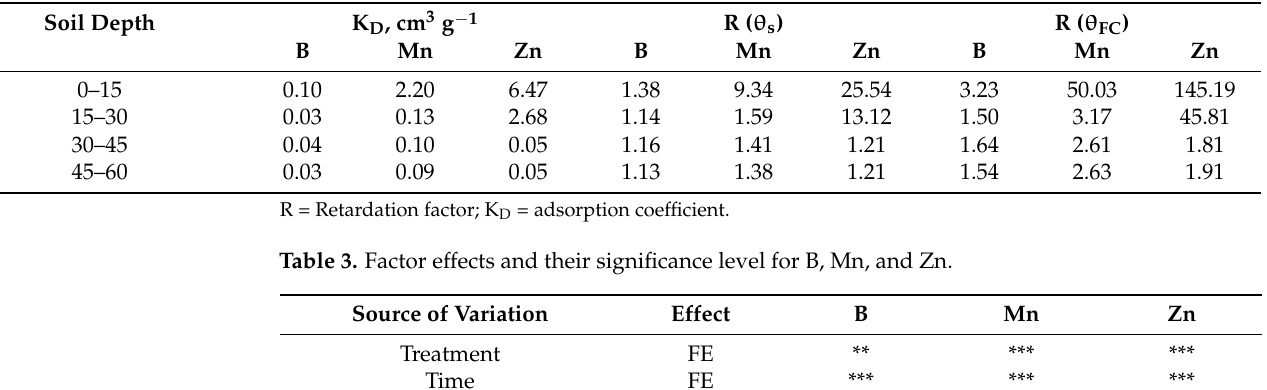
Table 2. Adsorption coefficient, retardation factor at soil saturation and field capacity across four soil depths from the soil surface.